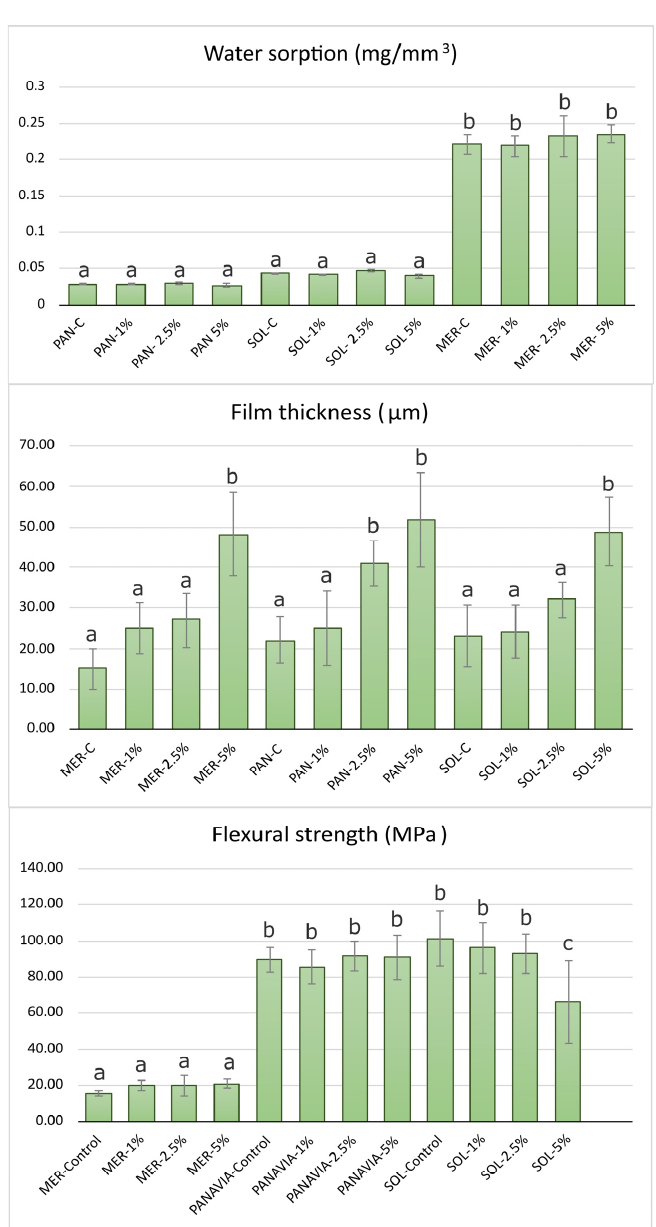
Figure 3. Mean values and SD (error bars) for water sorption, film thickness, and flexural strength of the composite specimens. Different letters suggest significant differences in the mean values. MER = Meron plus QM, MER − 1% = Meron plus QM with 1% wt zirconia NPs, MER − 2.5% = Meron plus QM with 2.5% wt zirconia NPs, MER − 5% = Meron plus QM with 5% wt zirconia NPs, PAN = Panavia SA Universal, PAN − 1% = Panavia SA Universal with 1% wt zirconia NPs, PAN − 2.5% = Panavia SA Universal with 2.5% wt zirconia NPs, PAN − 5% = Panavia SA Universal with 5% wt zirconia NPs, SOL = Solocem, SOL − 1% = Solocem with 1% wt zirconia NPs, SOL − 2.5% = Solocem with 2.5% wt zirconia NPs, SOL − 5% = Solocem with 5% wt zirconia NPs.